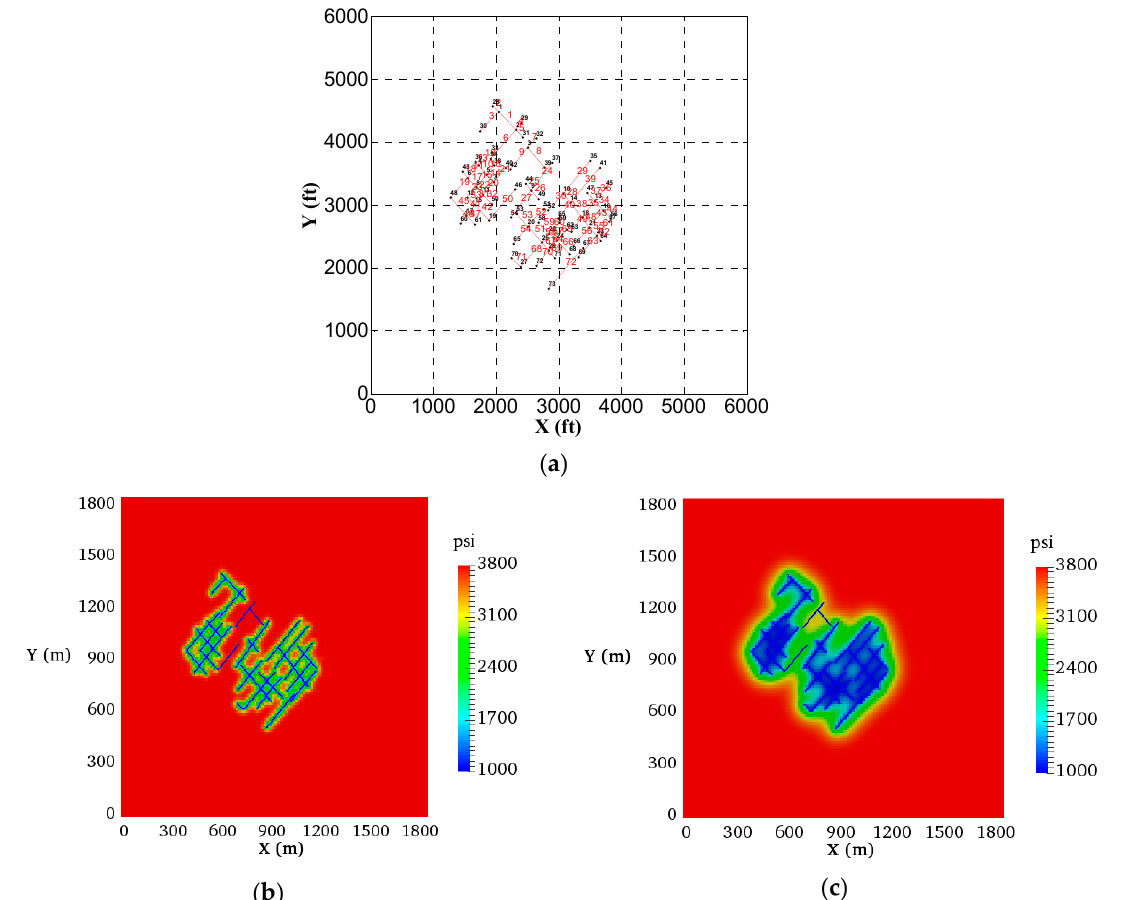
Figure 5. Shale gas model with fractures in Barnett shale with one horizontal well in Case 2: ( a ) Detection results of the nodes and lines with the proposed method; ( b ) the pressure profile after 3 years production; ( c ) the pressure profile after 10 years production.